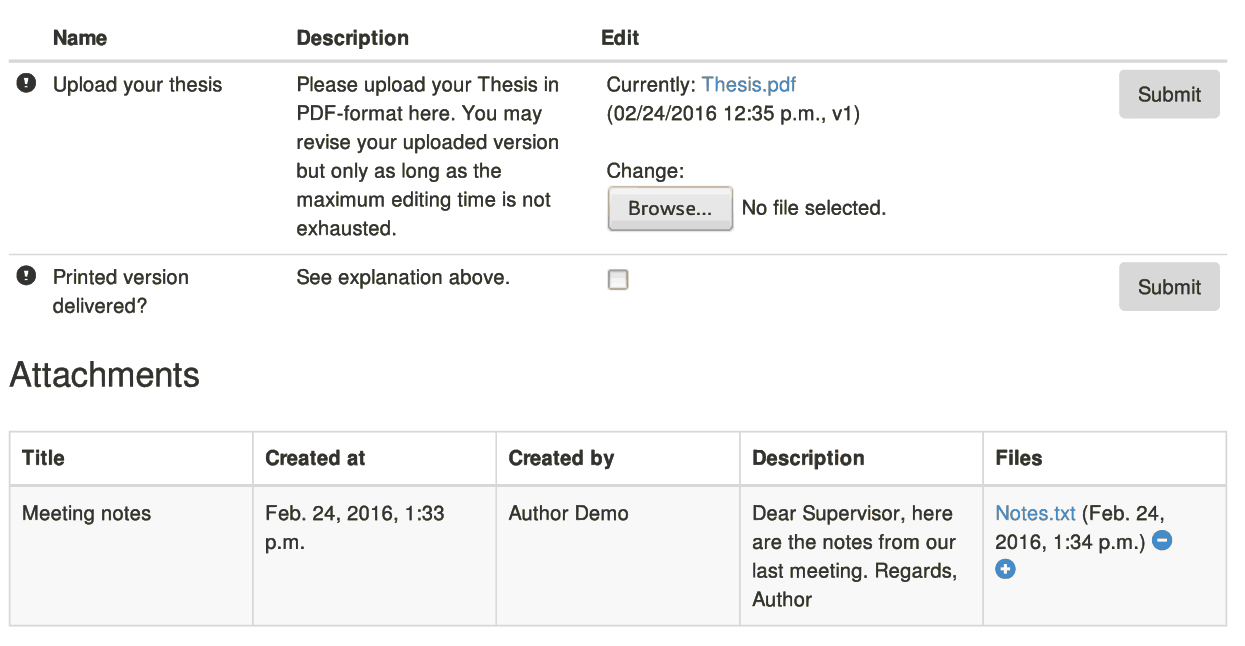
Figure 2. The subprocess “Delivery” from the supervisor’s point of view. Only the main part of the interface is shown, the page header (including global navigation bar and thesis title), sidebar on the right (including links to other views and information on the thesis), and the form to add new attachments at the bottom are